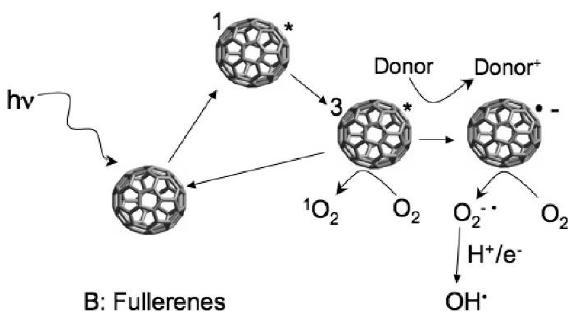
Figure 4. Mechanism of ROS production by fullerenes. Obtained from [69], with permission of the American Chemical Society